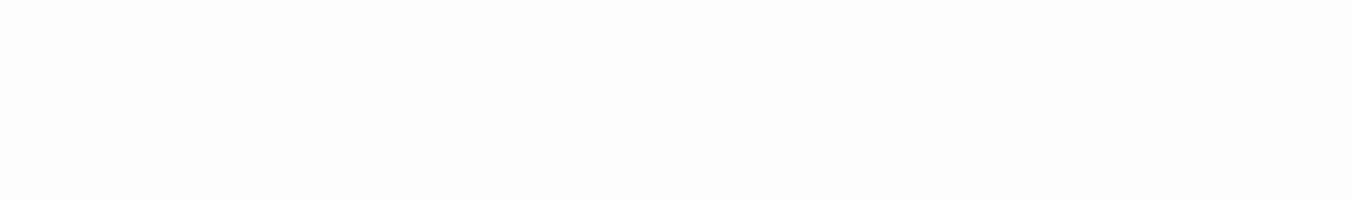
FIGURE 2 Time evolution of iodine concentration. (3.08 x 10-3M) while Noyes found a "stationary state" at 10-3M (but with different initial concen- trations of KIO3 and H +). We were ready to accept for this parameter a bigger value (5 x 10-3M) because of the larger temperature, but even the value of Noyes was never